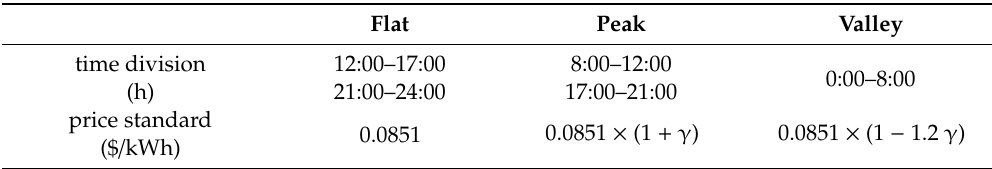
Table 4. The period division of the time-of-use